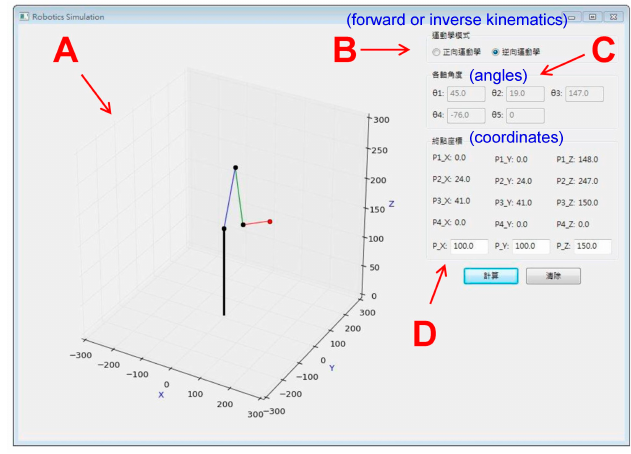
Figure 5. A graphical interface simulation of robotic motion with four features including: ( A ) Simulation chart; ( B ) Kinematic mode; ( C ) Angle of each axis; and ( D ) Coordinates of each axis.